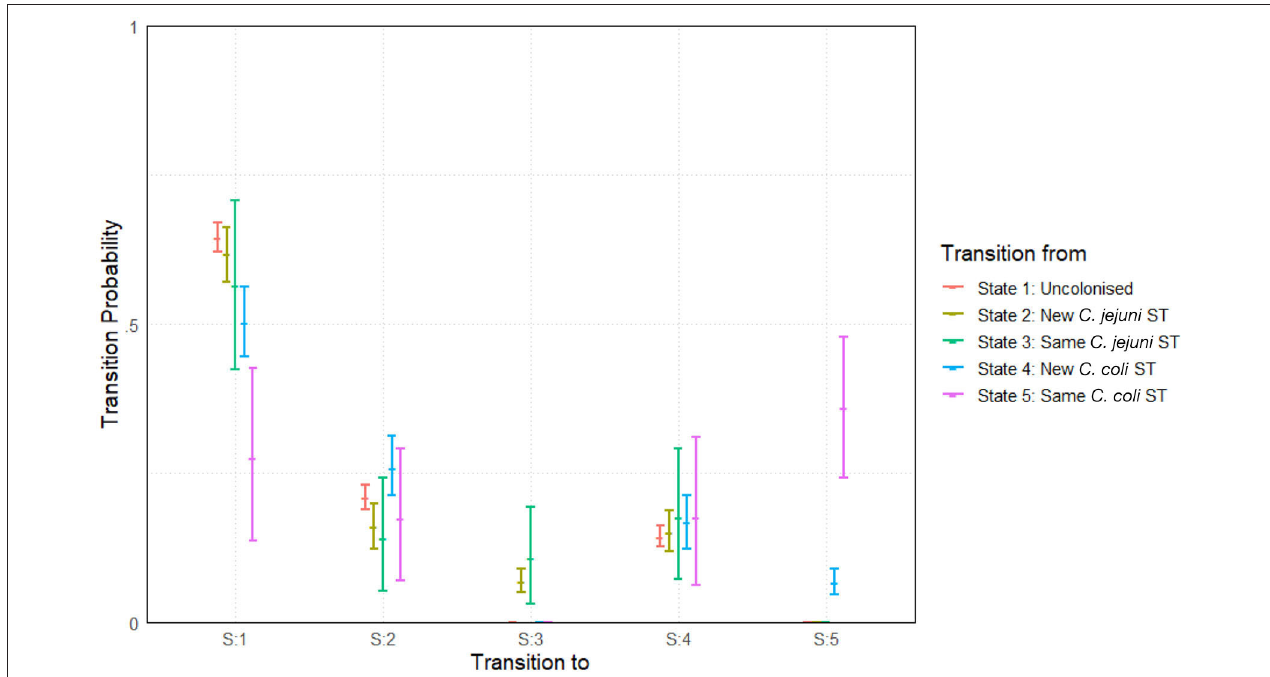
FIGURE 8 | Transition probabilities between five states, “uncolonized,” “colonized by a new C. jejuni ST,” “colonized by the same C. jejuni ST as previously,” “colonized by a new C. coli ST,” and “colonized by the same C. coli ST as previously.” Plots show the median values of the posterior distributions and the 95% highest density intervals